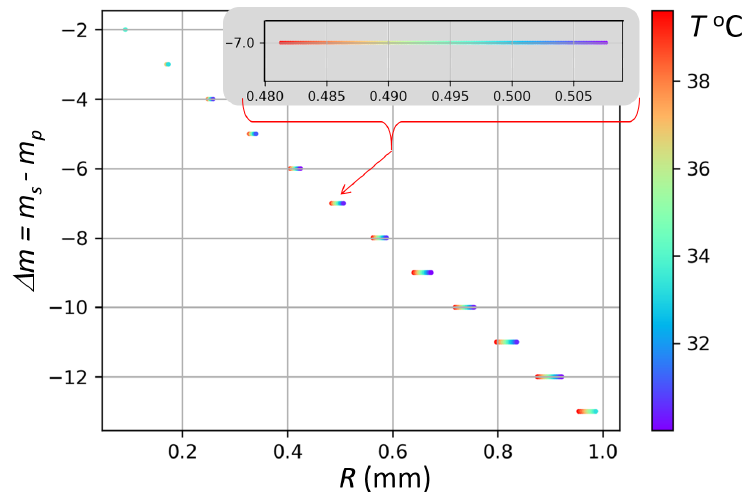
Figure 2. WGMs with different relative orbital numbers can be used for the 94.05 GHz RF signal upconversion in a TE–TM anti-Stokes process in Lithium Tantalate resonators of different radii at different